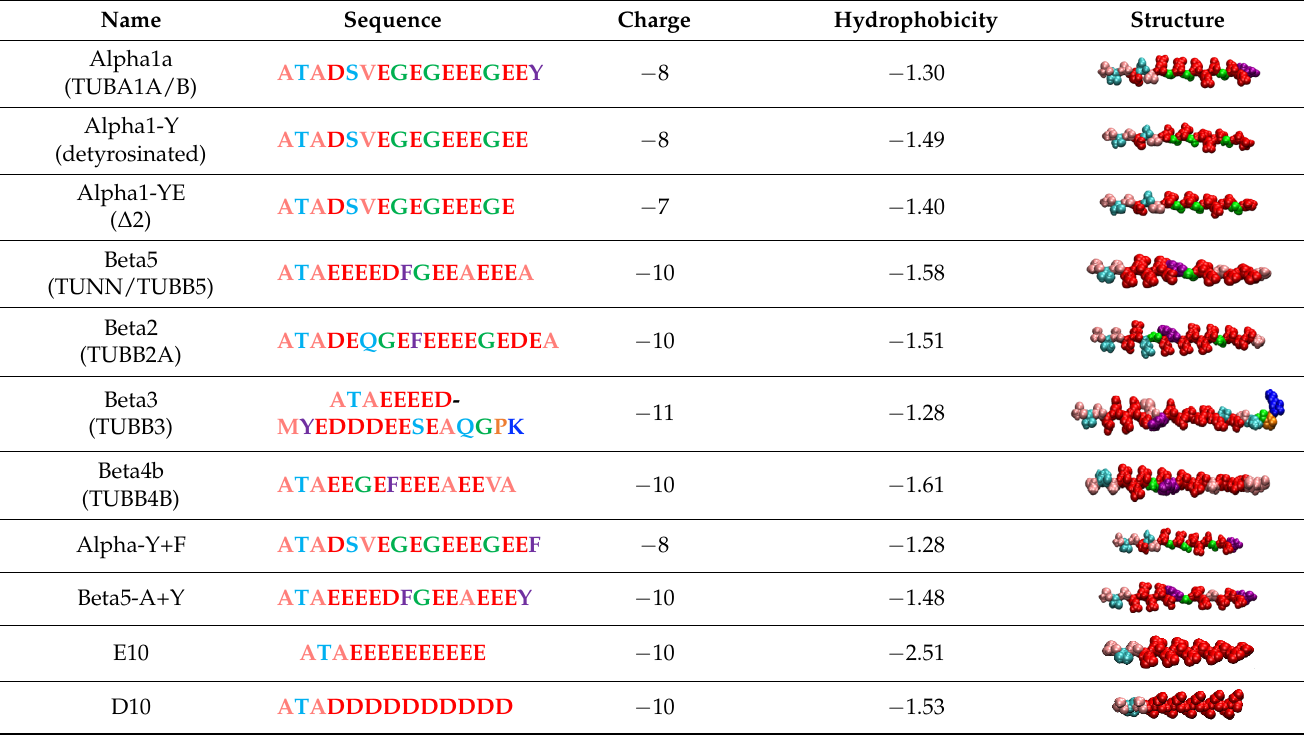
Table 1. CTT constructs used in this paper showing the name, sequence, total charge, hydrophobicity, and structure. Charge was determined from summing the positive and negative amino acids at pH 7.7. Hydrophobicity was determined using the Wimley-White scale, where a lower number is more hydrophobic and a higher number is less hydrophobic.